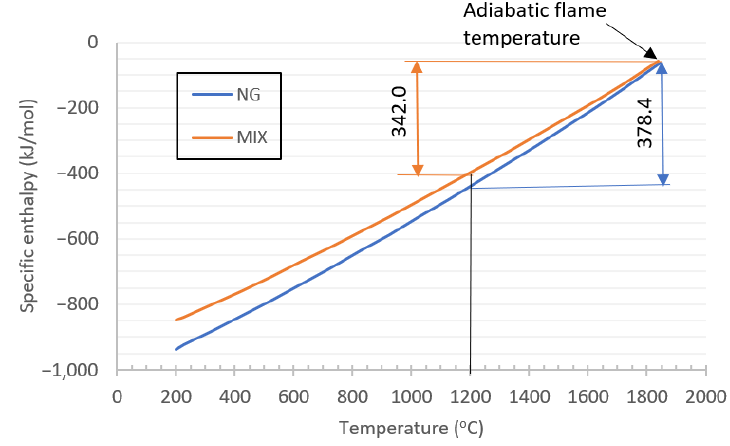
Figure 6. Enthalpy of combustion gases as function of temperature (T furnace = 1200 ◦ C; SC = 1.212; T air = 200 ◦ C).